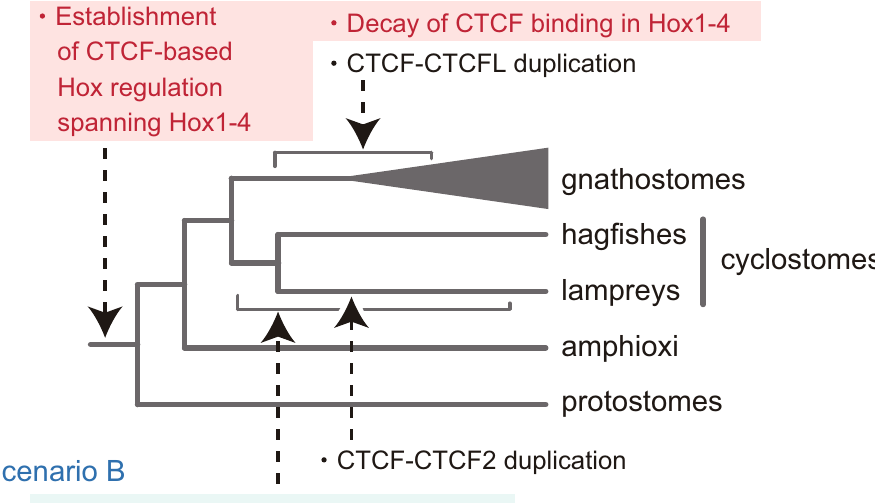
Figure 5. Possible scenarios of the establishment of CTCF binding patterns in vertebrate Hox clusters. Alternative evolutionary scenarios of CTCF gene duplication and CTCF binding patterns in Hox clusters are depicted. CTCF-based Hox regulation spanning Hox1-4 genes was established either at the ancestor of bilaterians (Scenario A) or in the cyclostome lineage (Scenario